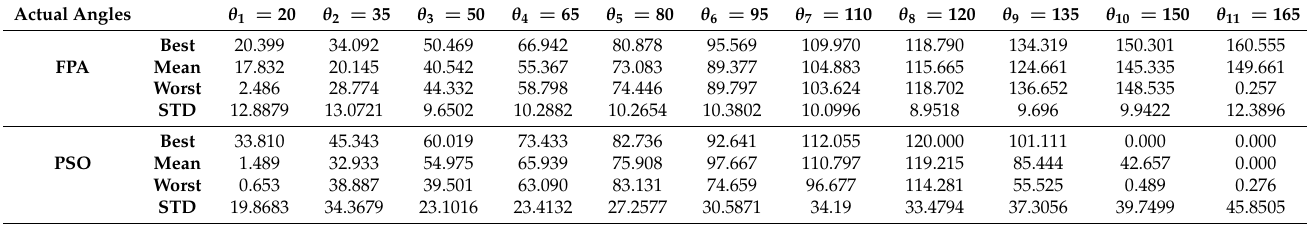
Table 7. Estimation accuracy and STD for eleven targets at SNR = 0